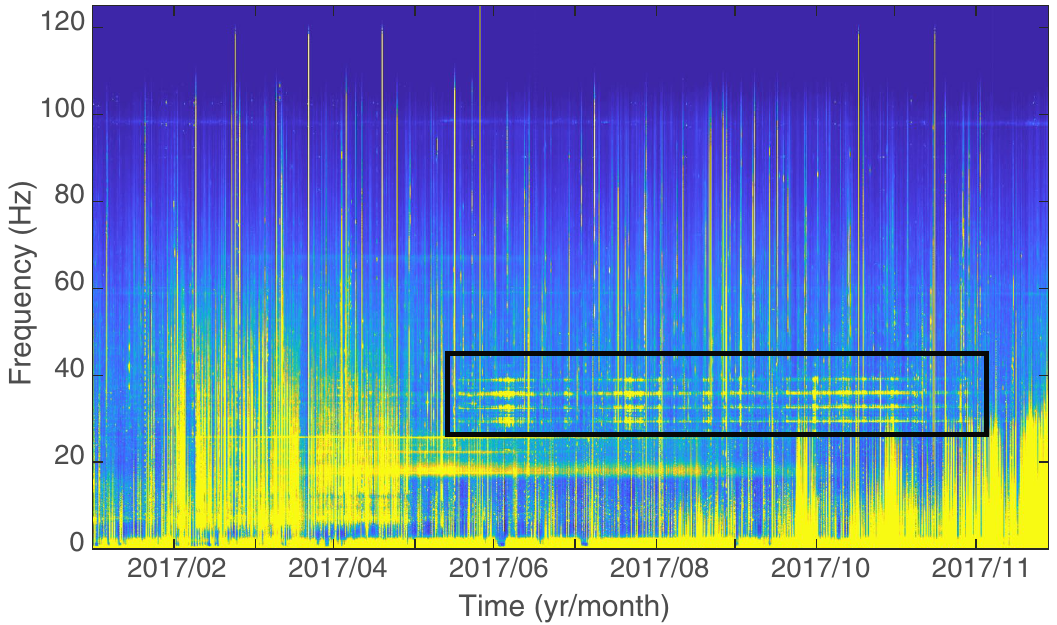
Figure 1. Long-term spectrogram of data recorded on the eastern side of the Chagos Archipelago (DGS site) in 2017: Chagos songs are a major component of the central Indian Ocean underwater soundscape and have been so for nearly two decades. The acoustic energy in the parallel horizontal frequency bands outlined in the black box are Chagos songs. Spectrogram parameters: 6 h averaging window, 50% overlap, FFT window of 120